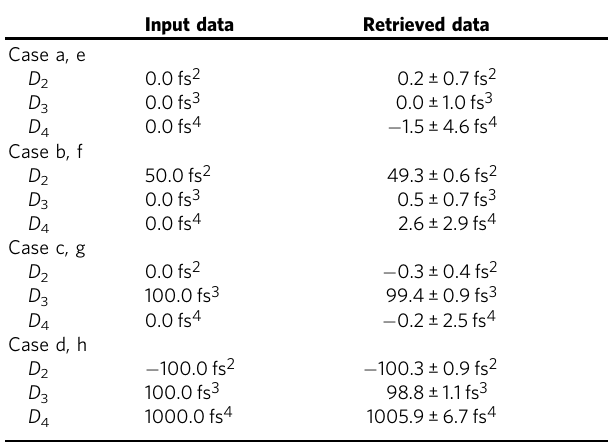
Tabulated data of cases a – d corresponding to the simulated time-delay traces of Fig. 2a – d and their respective dispersion functions plotted in Fig. 2e – h. Quoted errors are standard deviations of the mean value after ten repetitions of the